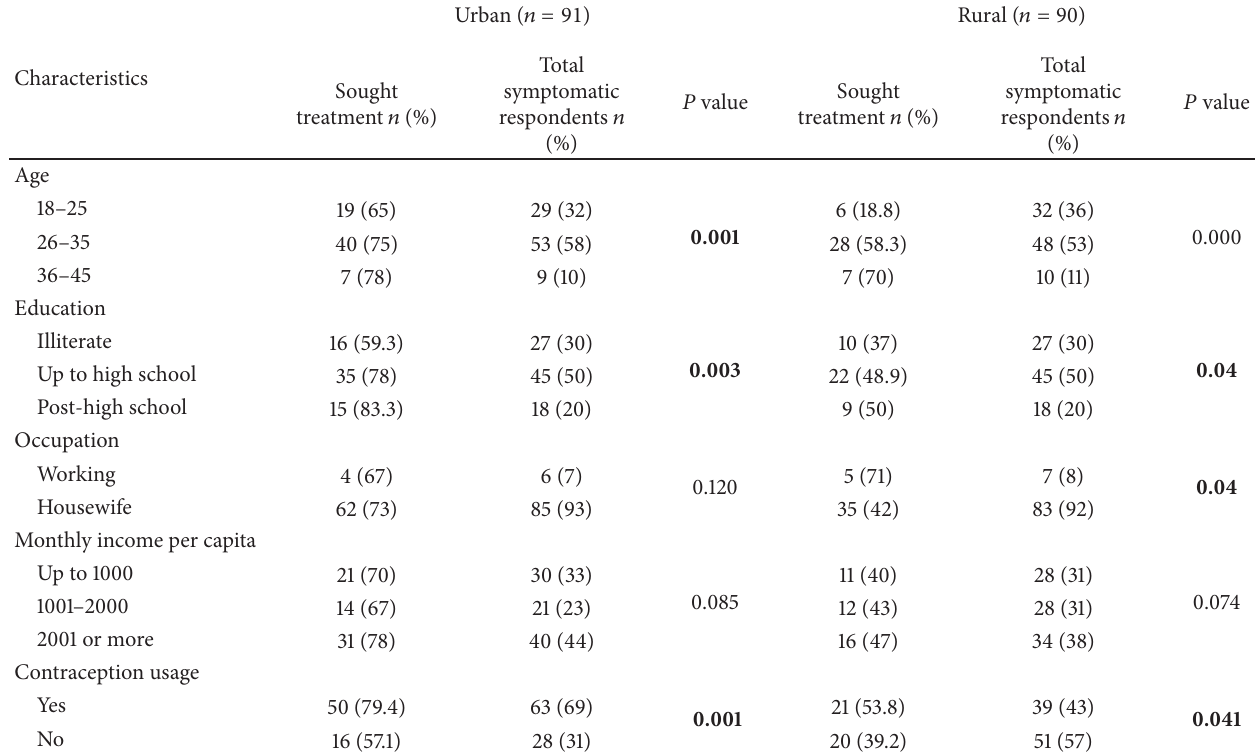
Table 6: Treatment seeking behaviour in relation to some sociodemographic, obstetric, and behavioural factors in urban and rural area.